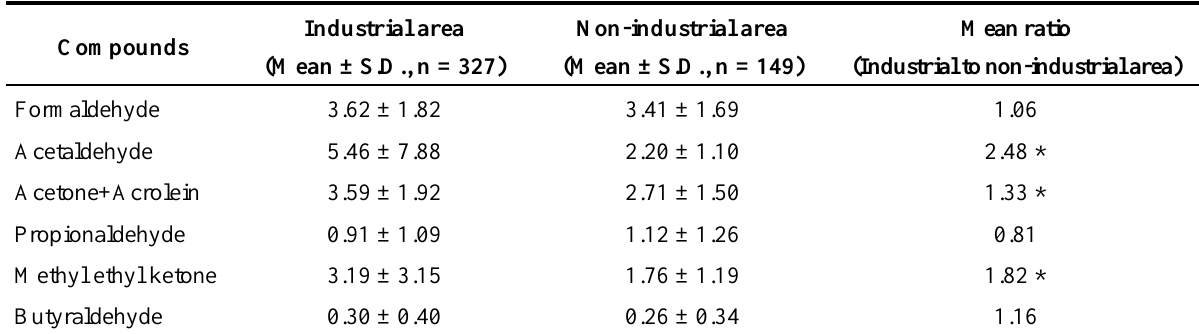
Table 5. Comparison of carbonyl concentrations (in ppb) in industrial and non-industrial areas.